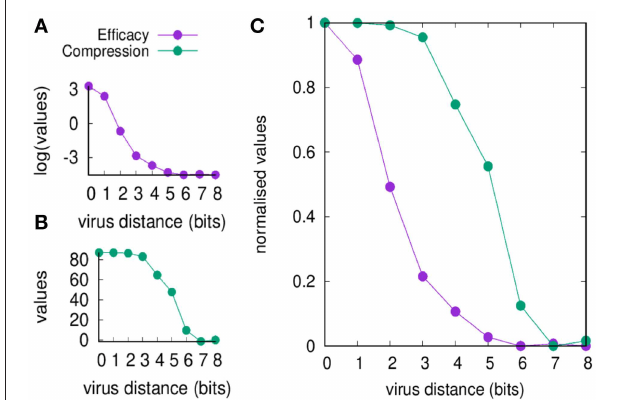
FIGURE 2 | Memory response clears the virus and dominates over any primary response by its faster action. This figure shows that the domination remains in place also when the antigenic distance d makes any cross-reactive memory response weak. In panel (A) , we show the efficacy of the immune response E ( d ) (i.e., a measure of cytotoxicity in unit of cell counts) vs. the antigenic distance d . In panel (B) , the compression C ( d ) (i.e., the blocking effect of the cross-reactive memory, also in unit of cell counts). The difference of the curves indicates that for d ∈ { 2 ... 5 } the blocking of the primary response is not justified by an efficient secondary response, that is the phenomenon that constitutes the MaN. Panel (C) presents the same data of panels (A,B) but respectively normalized by the Min-Max method (i.e., y ′ = ( y − y min ) / ( y max − y min )) so to fall within the same range [0,1]. It visualizes at once the effect of MaN as the area between the two curves assuming the shape of an